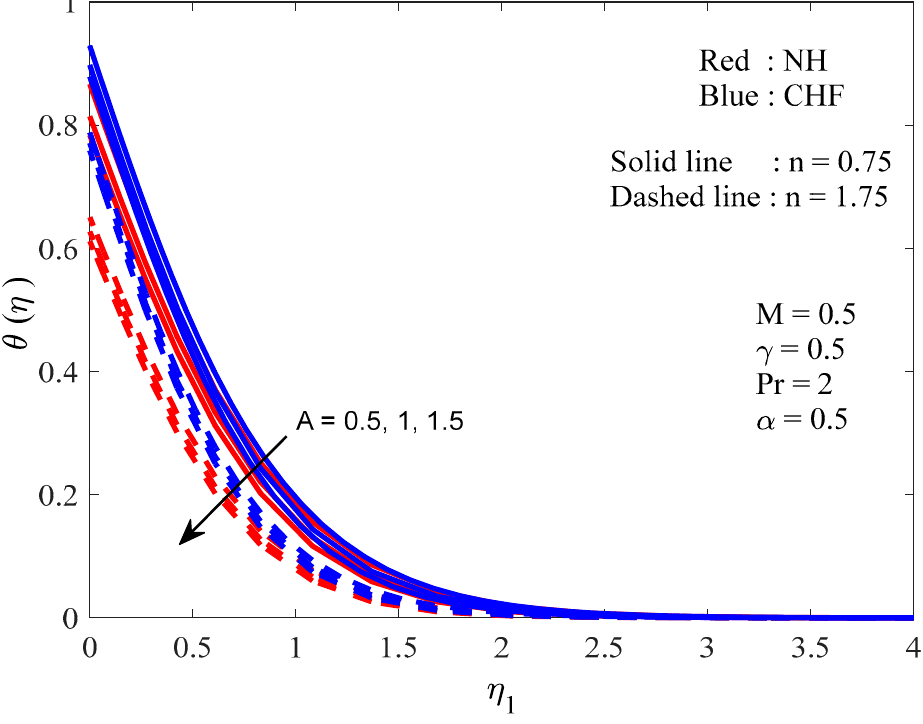
Figure 7. The temperature distribution profiles with the influence of A